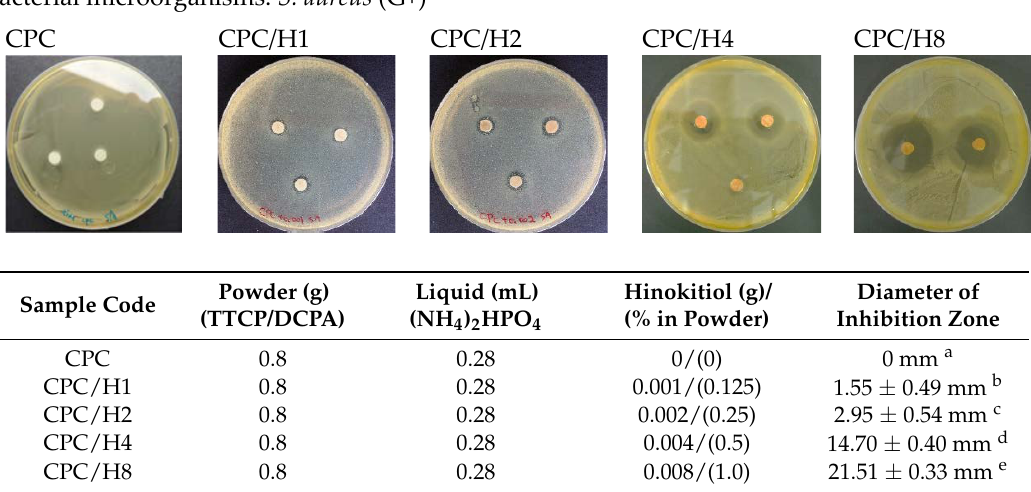
Figure 1. Inhibition zone ( S. aureus ) of CPC, CPC contained 0.001 g hinokitiol (CPC/H1), CPC contained 0.002 g hinokitiol (CPC/H2), CPC contained 0.004 g hinokitiol (CPC/H4), and CPC contained 0.008 g hinokitiol (CPC/H8). The data in the same statistical level was marked with the same letter (a, b, c, d, and e) after the data.